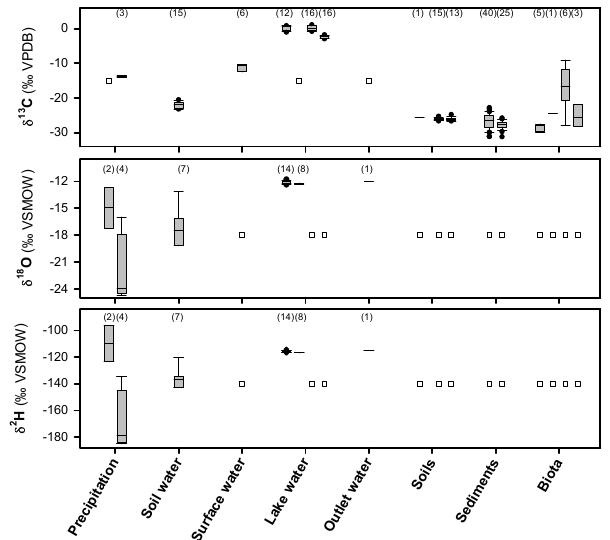
Figure 11. Box plot showing the isotopic composition of carbon, oxygen and hydrogen in different sample types. For water samples the ∂ 13 C is determined on DIC only, while for solid samples the measurements were made on total carbon. The two boxes for pre- cipitation represent rain (left) and snow (right). The four boxes for lake water represent (from left to right) surface and bottom wa- ter from locations other than the lake centre and surface and bot- tom water from the lake centre. The three boxes for soils represent silt (left), peaty-silt active layer (middle) and peaty-silt permafrost (right). The two boxes for sediments represent samples collected from water depths <14m (left) and >14m (right), respectively. The four boxes for biota represent (from left to right) terrestrial primary producers, terrestrial consumers, aquatic primary produc- ers and aquatic consumers. The boxes denote the median and the 25th and 75th percentiles, while the whiskers denote the 10th and 90th percentiles. Outliers are marked with a black dot, and the open squares mark that no data are available for this sample type. The numbers within parenthesis represent the number of samples for each sample